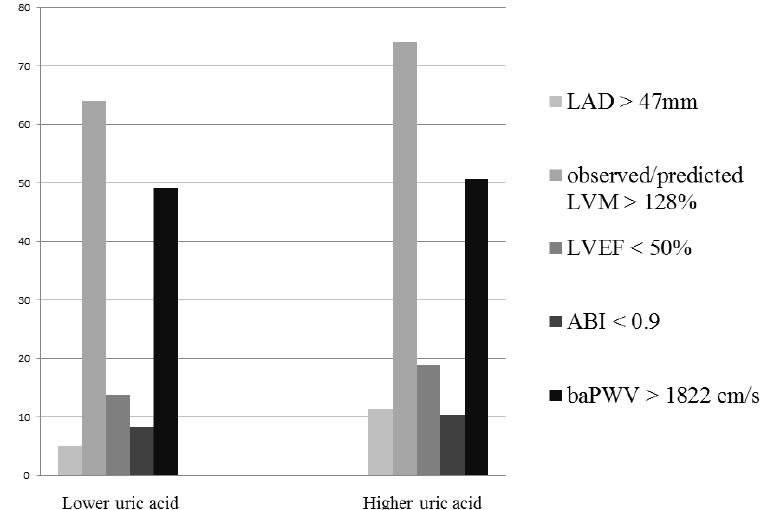
Figure 1. There was a significant higher prevalence of left atrial diameter (LAD) < 47 mm (5.1% vs. 11.4%, p = 0.017) and observed/predicted left ventricular mass (LVM) > 128% (64.1% vs. 74.1%, p = 0.026) in the high uric acid group, but not left ventricular ejection fraction (LVEF) < 50% (13.8% vs. 18.9%, p = 0.160), ankle-brachial index (ABI) < 0.9 (8.3% vs. 10.4%, p = 0.450) or brachial-ankle pulse wave velocity (baPWV) > 1822 cm/s (49.3% vs. 50.7%, p = 0.769).